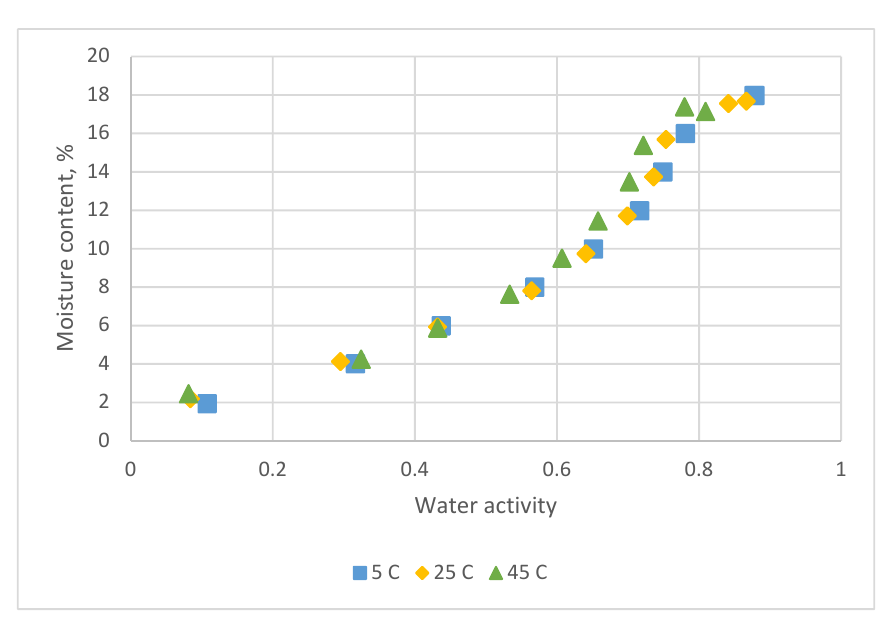
Figure 2. Sorption data for C. morifolium flowers obtained at 5 °C, 25 °C and 45 °C by the equilibrium relative humidity method.